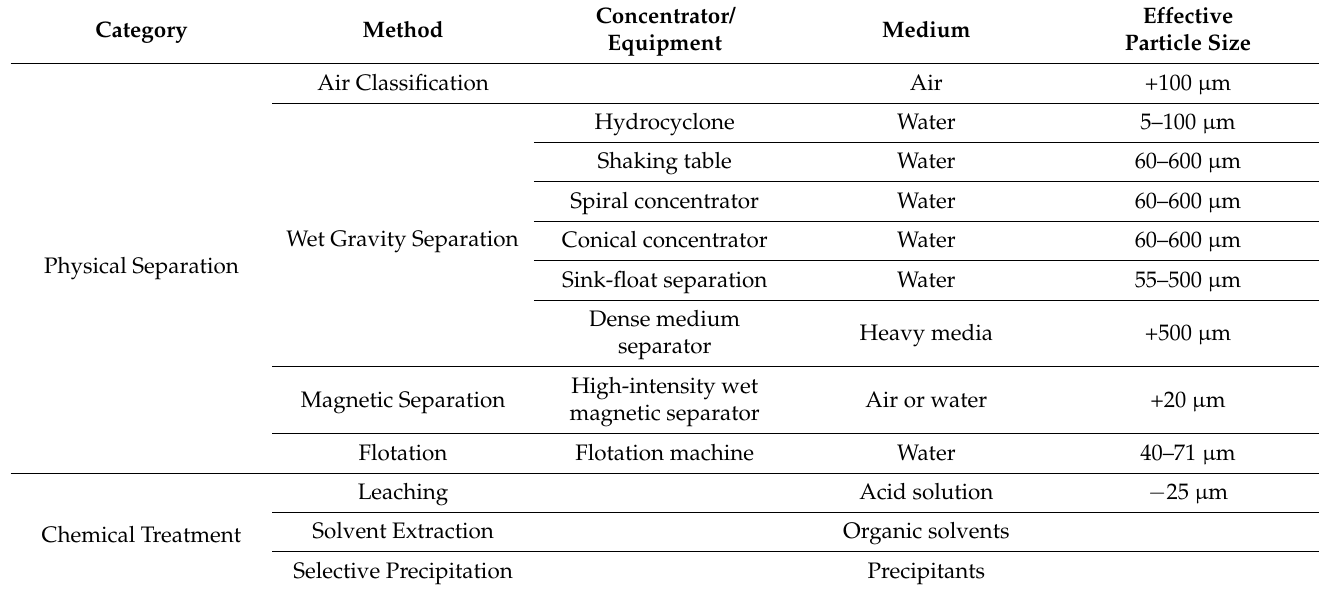
Table 1. Main methods employed for recovering REYs from coal ashes, indicating the type of concentrator and medium, as well as the effective range of particle